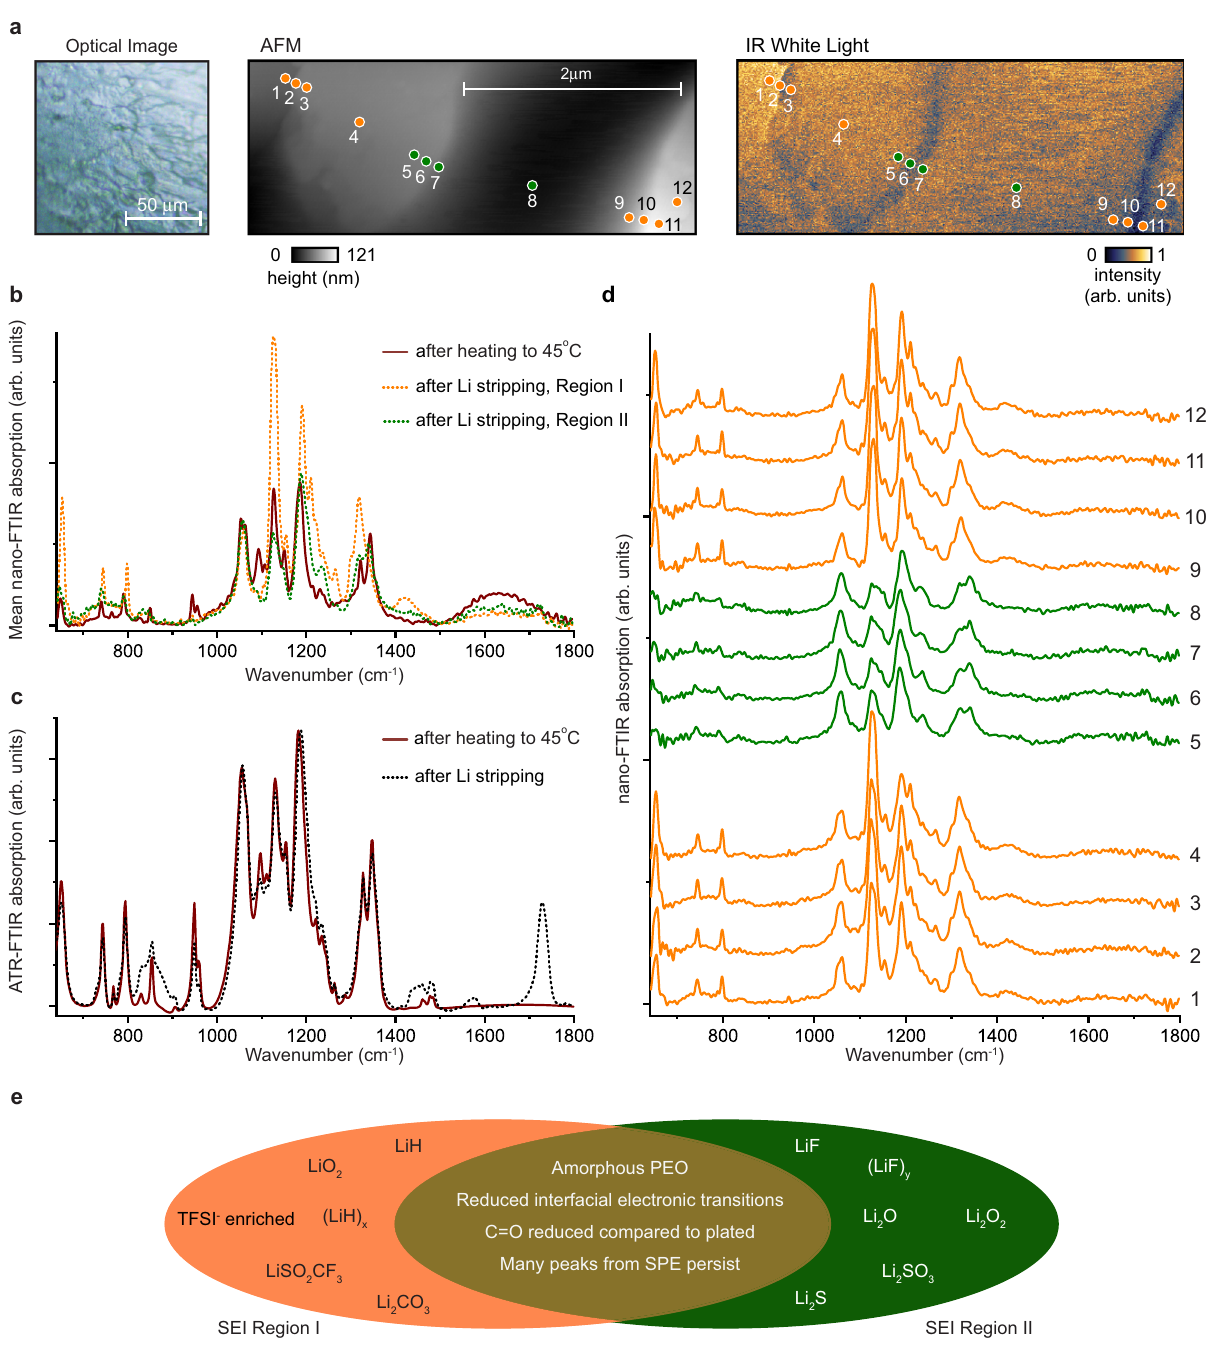
Fig. 4 Characterization of the G/SEI/SPE interface after Li stripping. a Optical, atomic force microscopy (AFM), and infrared (IR) white light images of the G/SEI/SPE interface. b Average nano-FTIR spectra of the interface after heating to 45 °C and after Li stripping from the two SEI regions indicated by the colored locations in a. c ATR-FTIR spectra of the interface after heating to 45 °C and after Li stripping. d Individual nano-FTIR spectra of the G/SEI/SPE interface after Li stripping. Spectra are numbered and color-coded according to the locations in a . e Venn diagram depicting key similarities and differences between the two predominate SEI